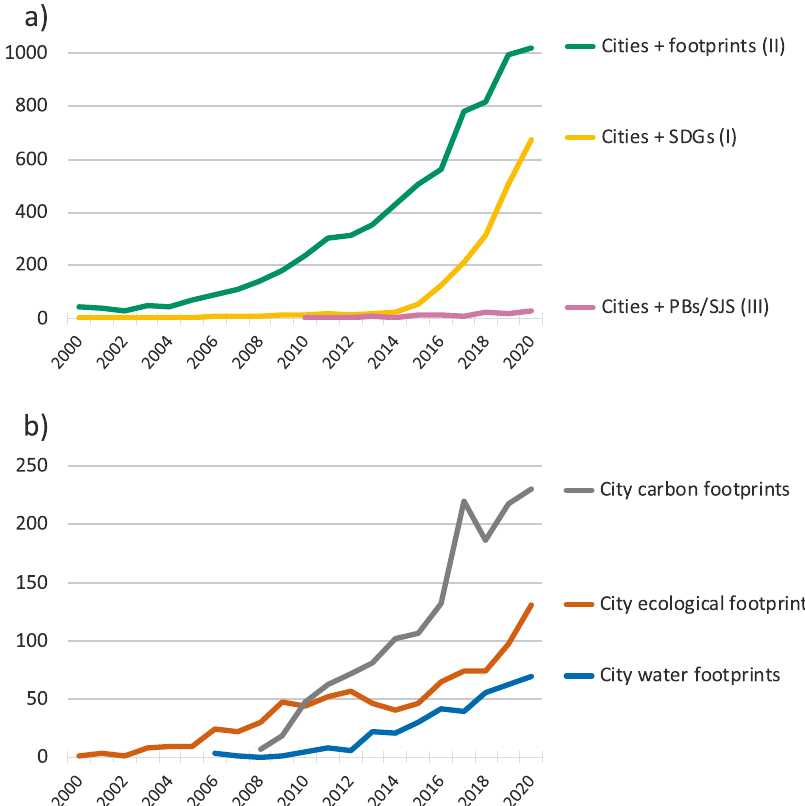
Fig. 2 Number of published academic papers relevant to this review. The graphs show the number of published articles per year between 2000 and 2020 on topics related to cities, footprints, Sustainable Development Goals (SDGs) and planetary boundaries or safe and just operating space (PBs/SJS) as documented in the Web of Science database (for search strings see Supplementary Data). a Provides details of aggregate numbers in Fig. 1 on the three main literature areas of this review. b Provides details of aggregate numbers in Fig. 3 on selected footprint studies of